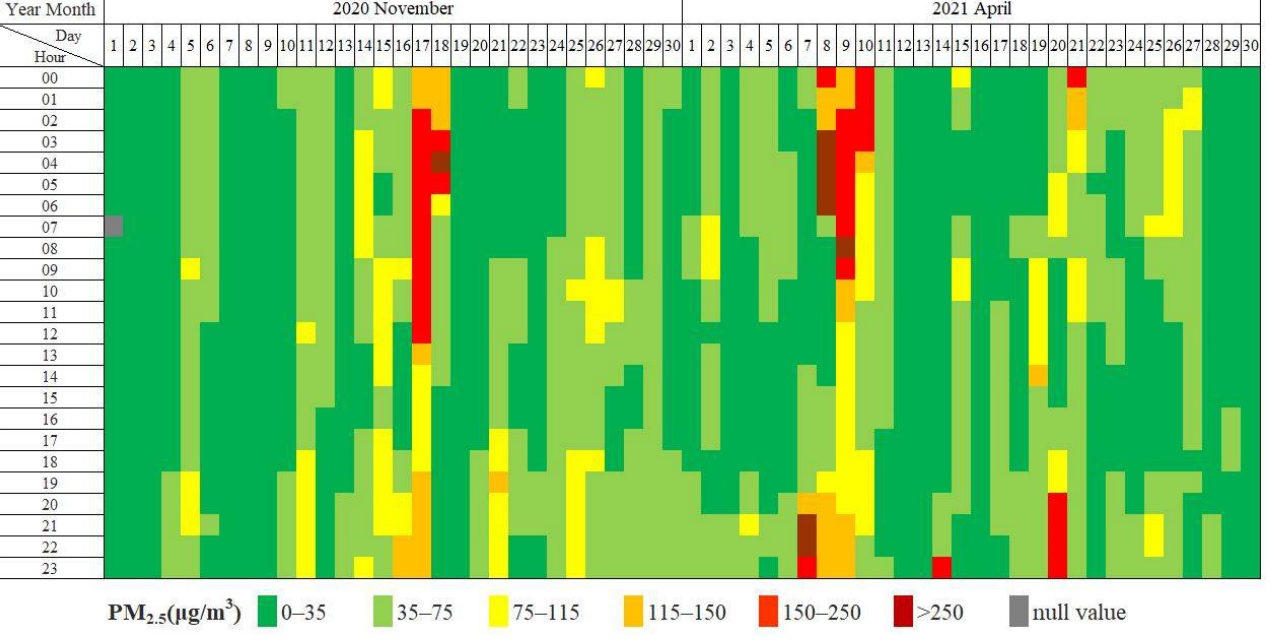
Figure 5. Calendar plot of hourly PM 2.5 concentrations of Changchun during the SOB season of 2020–2021. Table 1. PM 2.5 pollution episodes in Changchun during the SOB season of 2020–2021.